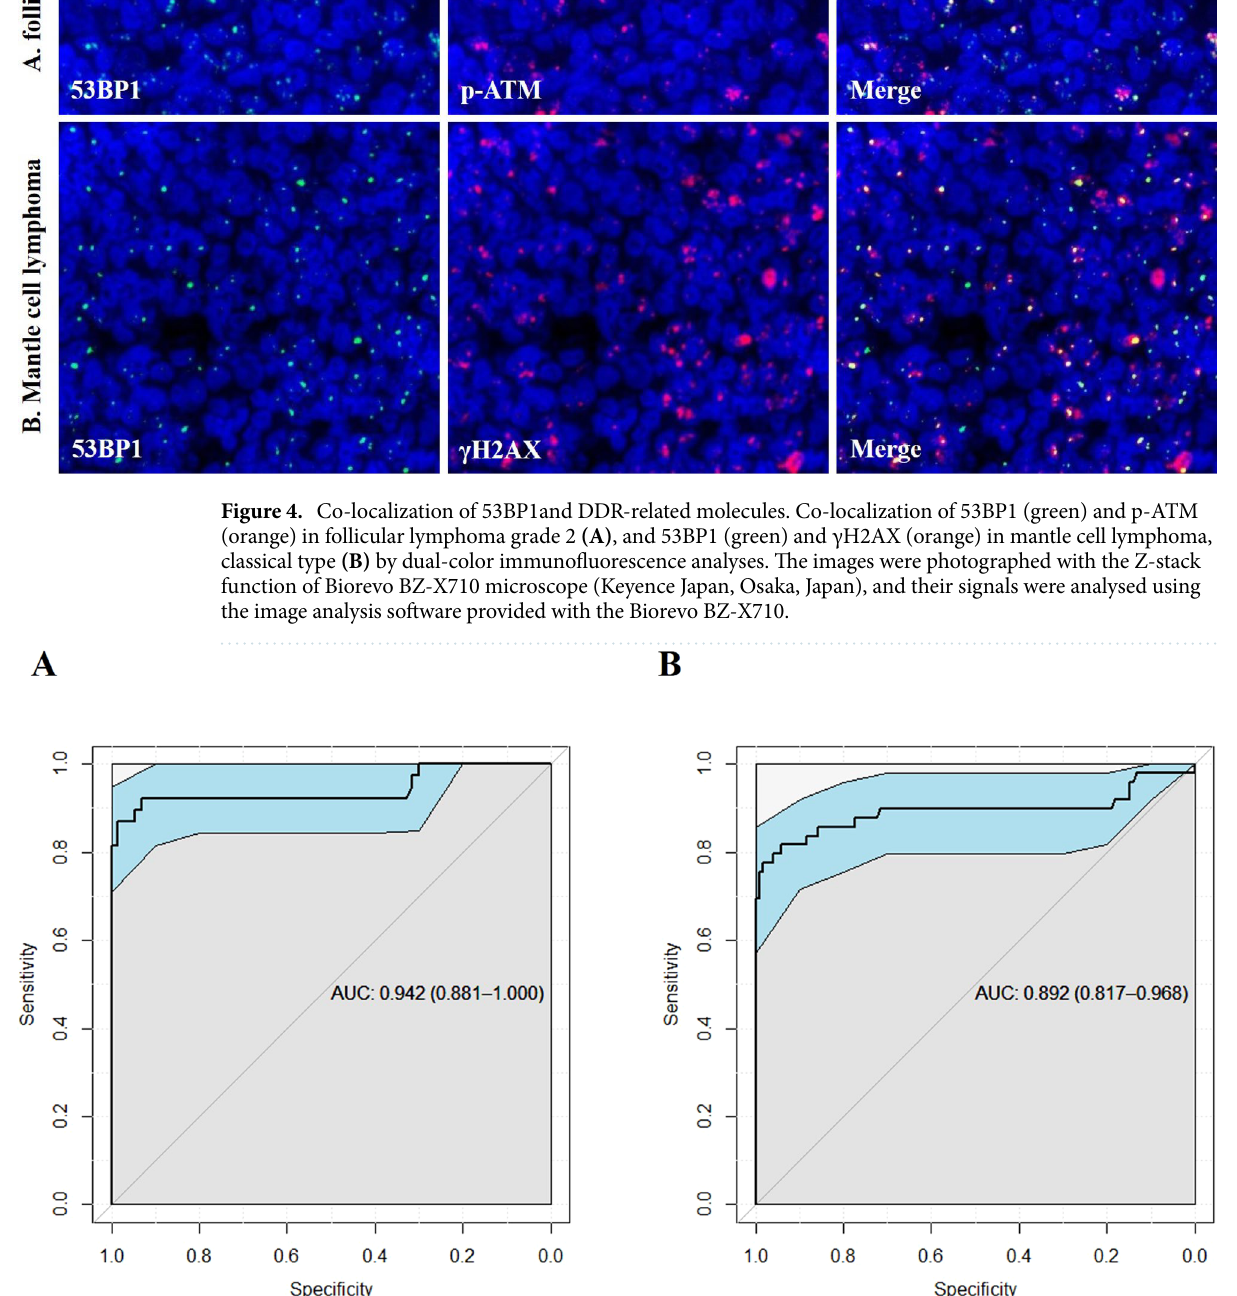
Figure 5. ROC curves for detecting malignant lymphomas using the ratio of abnormal types of 53BP1 expression by immunofluorescence. (A) ROC curve for follicular lymphoid proliferative lesions, such as follicular lymphomas vs. germinal center (n = 111). Area under the curve is 0.942 (95% confidence interval, 0.861–1.000, p < 0.0001, logistic regression model). (B) ROC curve for small cell lymphoid proliferative lesions, such as mantle cell lymphoma vs. mantle-marginal zone (n = 169). Area under the curve is 0.892 (95% confidence interval, 0.817–0.968, p < 0.0001, logistic regression